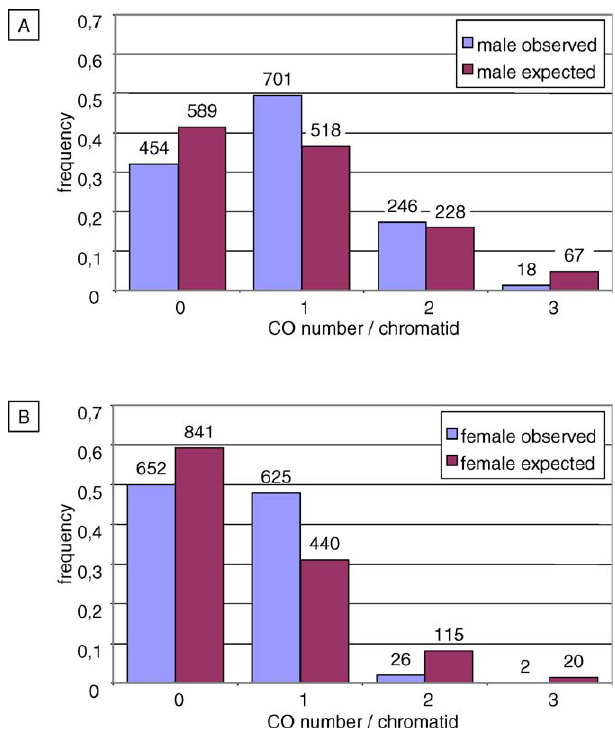
Figure 3. Distributions of CO Number per Chromosome 4 Bars represent the frequency of chromatids with 0, 1, 2, or 3 COs. (A) Observed (blue) and Poisson (purple) distributions in M population. (B) Observed (blue) and Poisson (purple) distributions in F population. Corresponding number of chromatids is indicated above each bar.